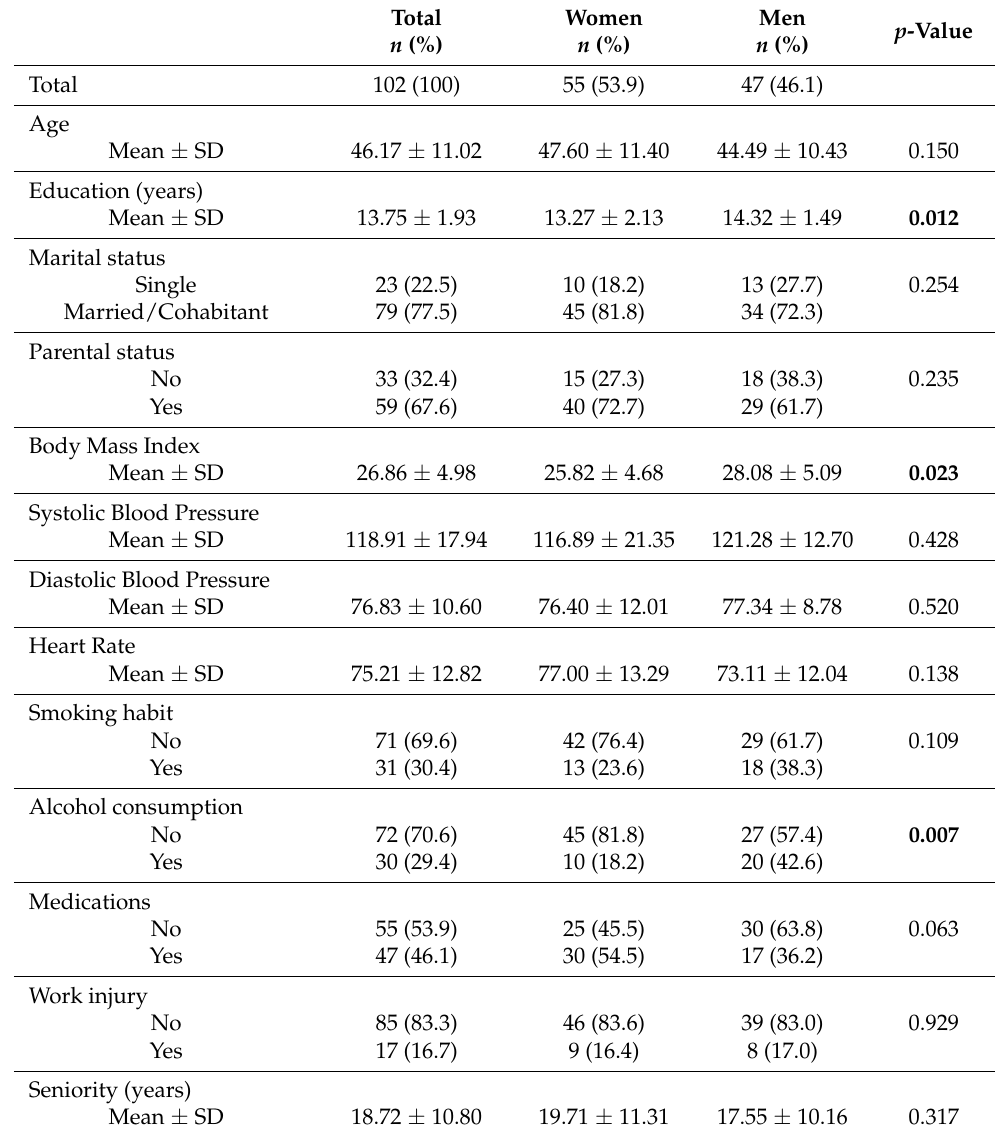
Table 1. Description of study population, differences upon stratification into male and female